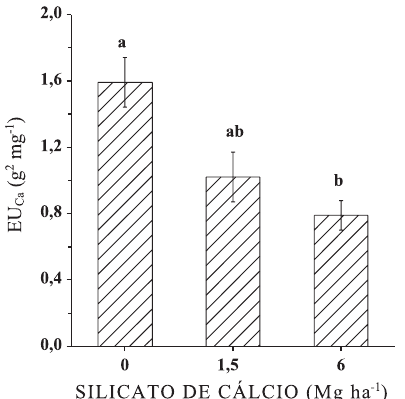
Figura 3. Eficiência de utilização do Ca de cafeeiros após 130 dias da adubação silicatada. Cada histograma representa o valor médio de três repetições (± erro-padrão). Letras distintas entre tratamentos indicam diferença estatística pelo teste de Tukey (p < 0,08).